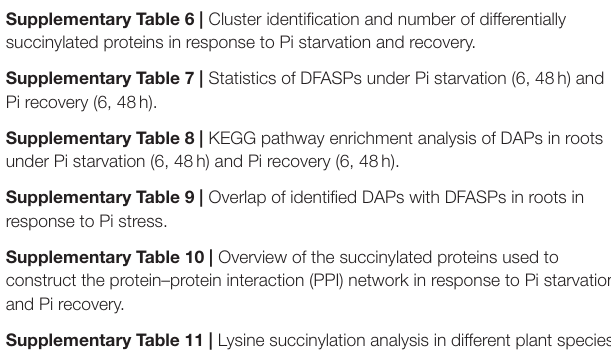
Supplementary Table 6 | Cluster identification and number of differentially succinylated proteins in response to Pi starvation and recovery. Supplementary Table 7 | Statistics of DFASPs under Pi starvation (6, 48h) and Pi recovery (6, 48h).